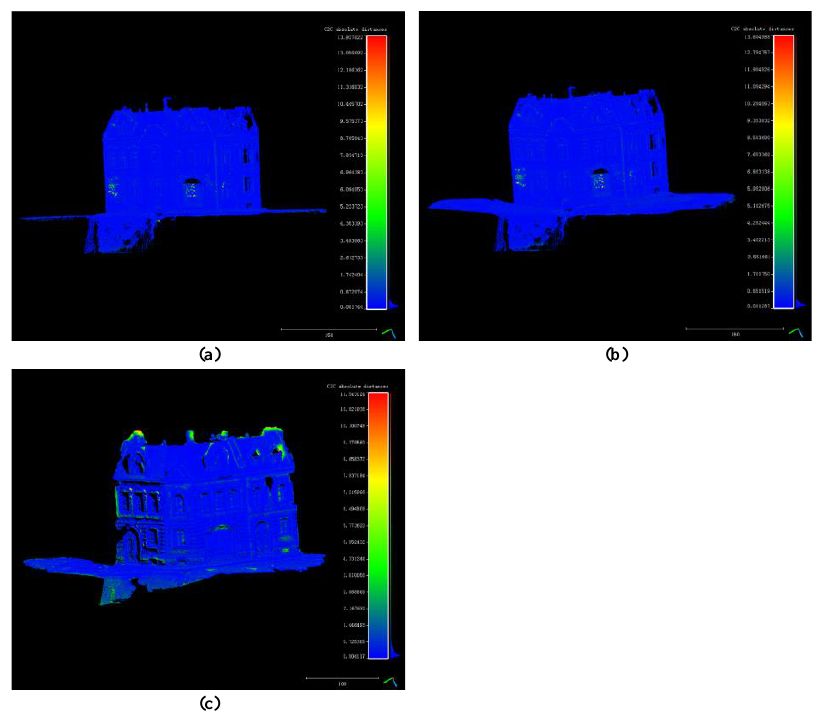
Figure 11. ( a ) Distance point cloud between the proposed method’s result and the standard point cloud; ( b ) Distance point cloud between openMVG + openMVS’s result and the standard point cloud; ( c ) Distance point cloud between MicMac’s result and the standard point cloud.